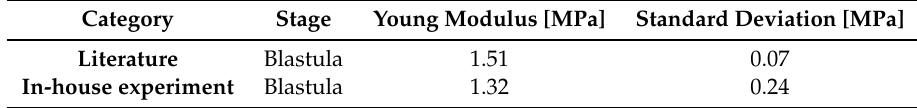
Table 3. Comparison between experimental result and literature for the Young’s modulus.